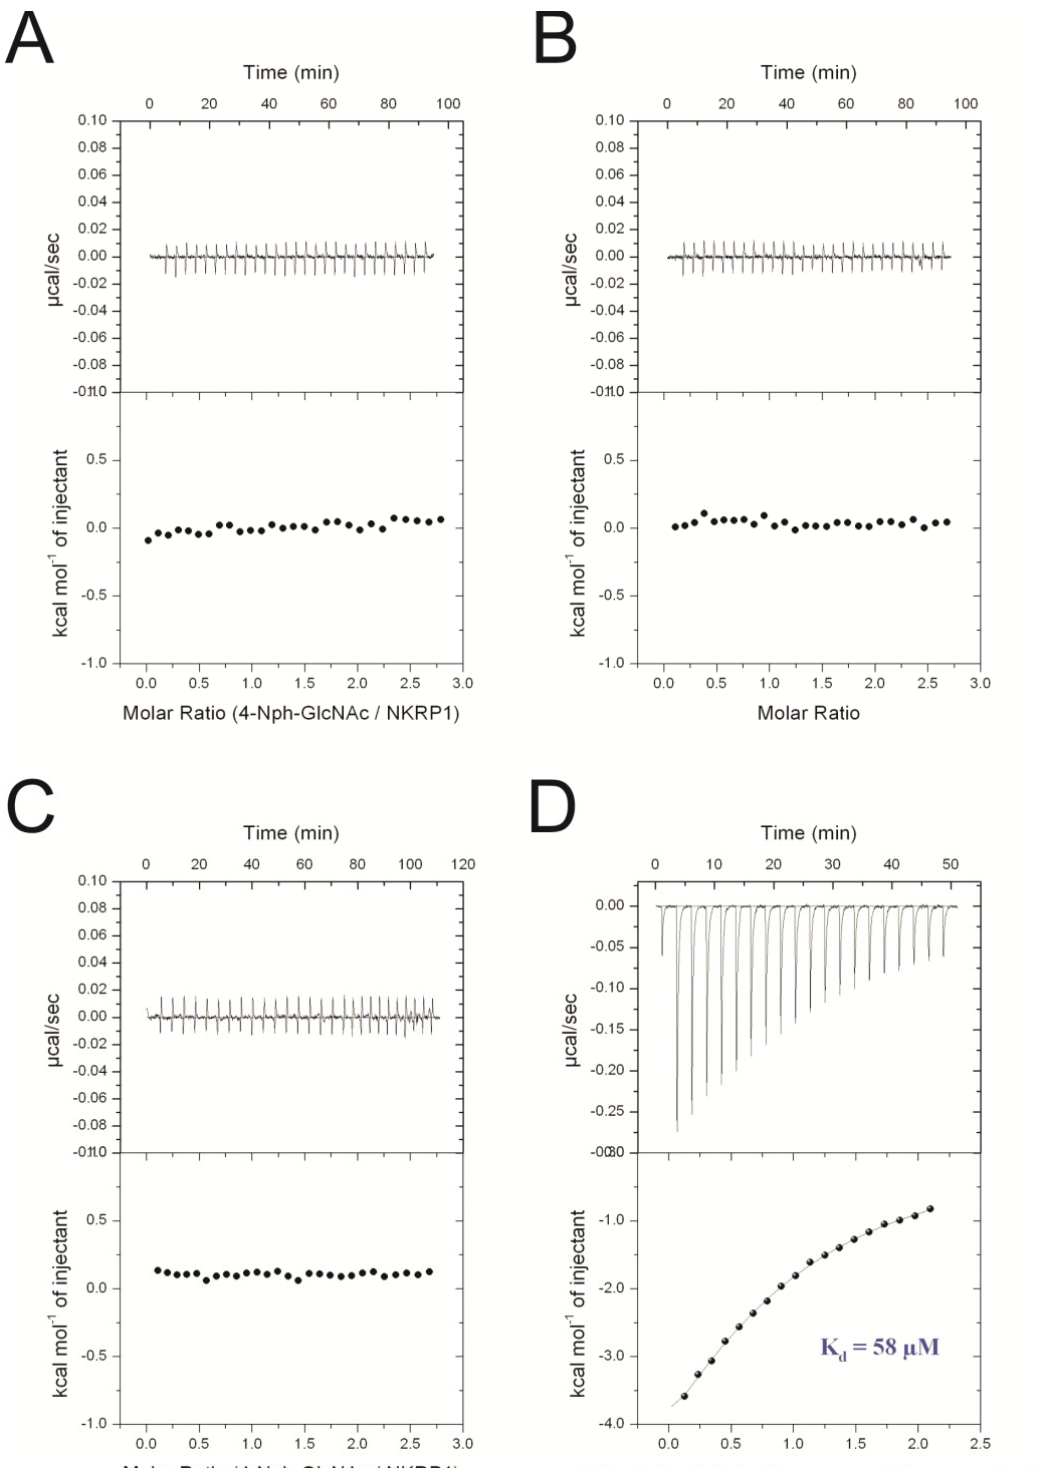
Figure 2. Isothermal titration of rat NKR-P1A with p NP-GlcNAc ( A ) and a corresponding control dilution in which p NP-GlcNAc was injected into a sample cell containing buffer alone ( B ); Microcalorimetry titration of rat NKR-P1A was also performed with p NP-GlcNAc supplemented with 10 mM CaCl ( C ) due to potential calcium-dependent 2 binding; Isothermal titration of p NP- α -mannose with Concanavalin A was used as a positive control ( D